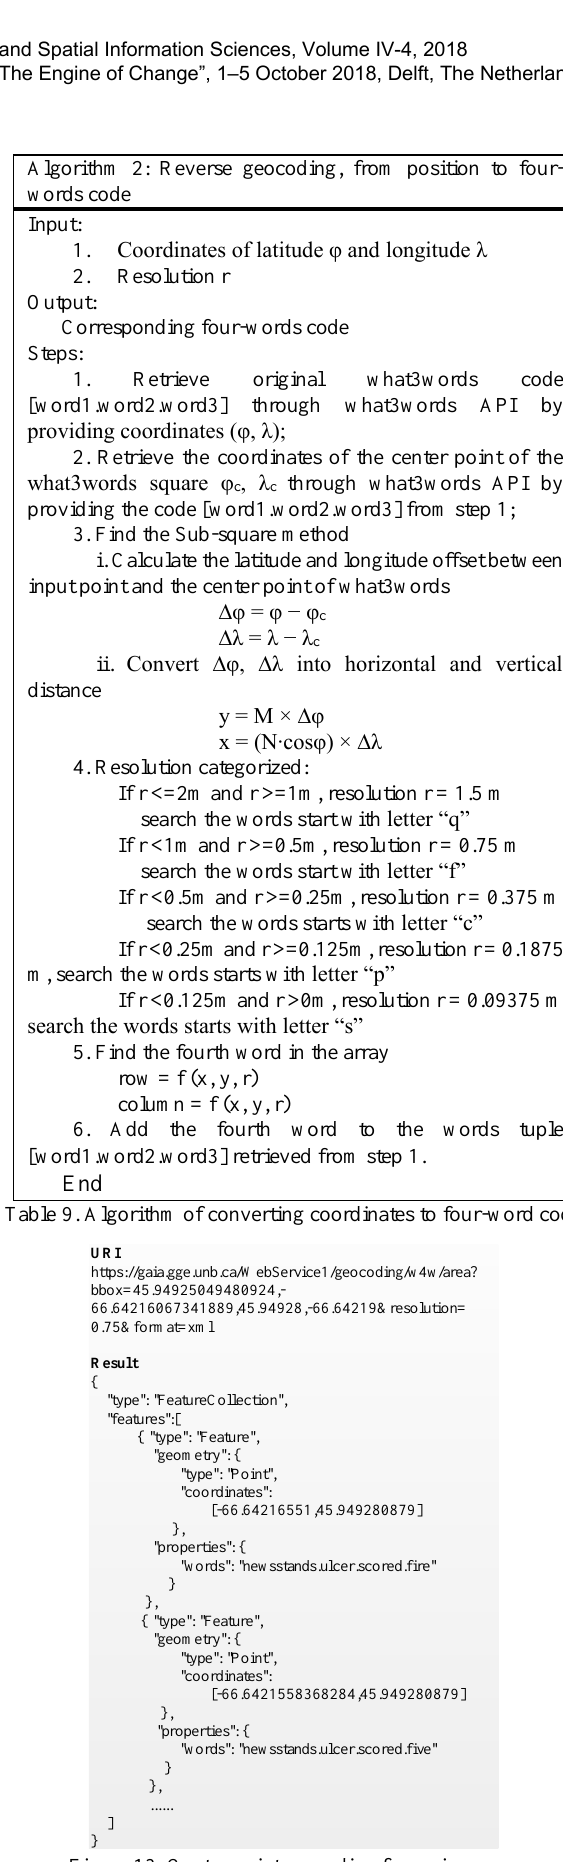
Figure 13. Centre points encoding for a given